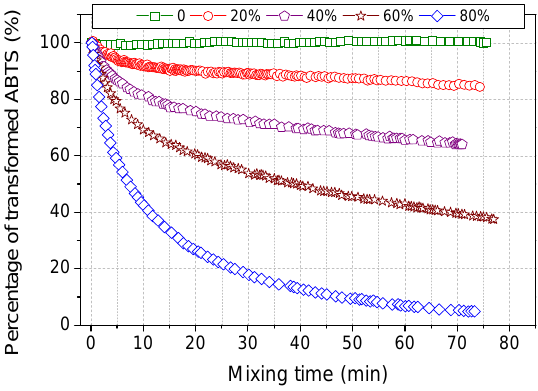
Figure 2. Effects of acetone content on kinetic transformation of ABTS radicals.